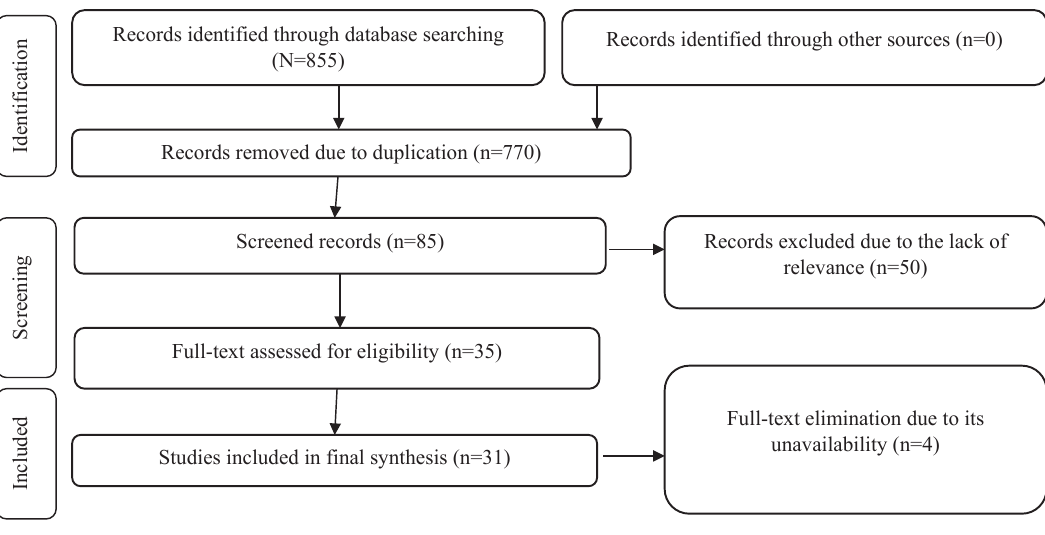
Figure 1. PRISMA Flowchart of Preliminary